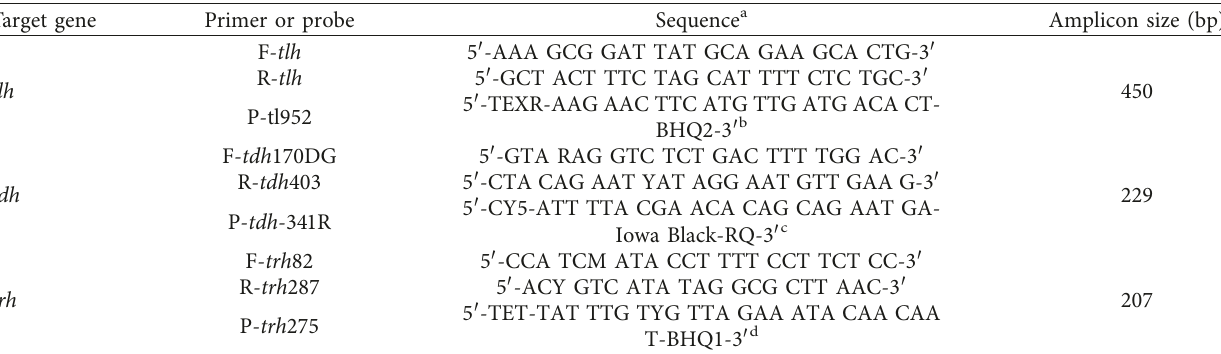
Table 2: Primers and probes for multiplexed polymerase chain reaction-based detection of total and pathogenic Vibrio parahaemolyticus (Ward and Bej [12]).